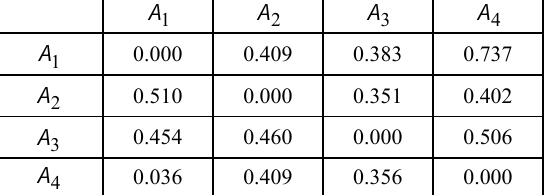
Table 17. The overall preference index of each logistics